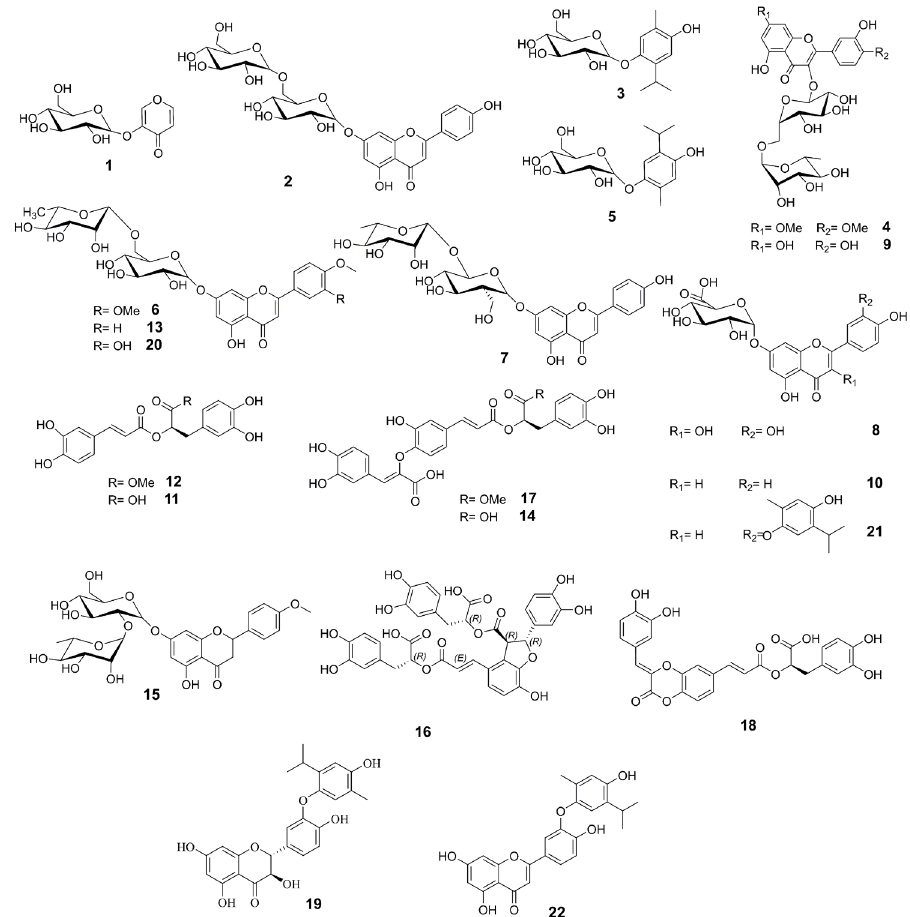
FIGURE 2 - Structures of compounds